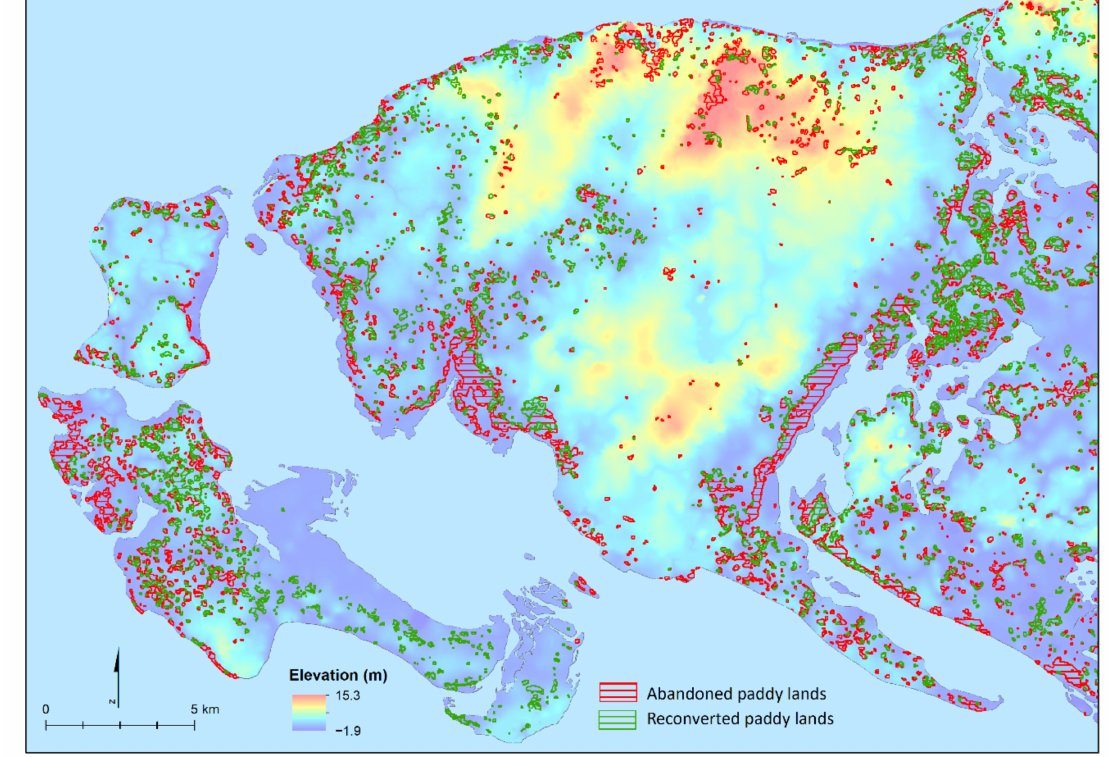
Figure 6. Permanently abandoned paddy lands and reconverted paddy lands overlaid on